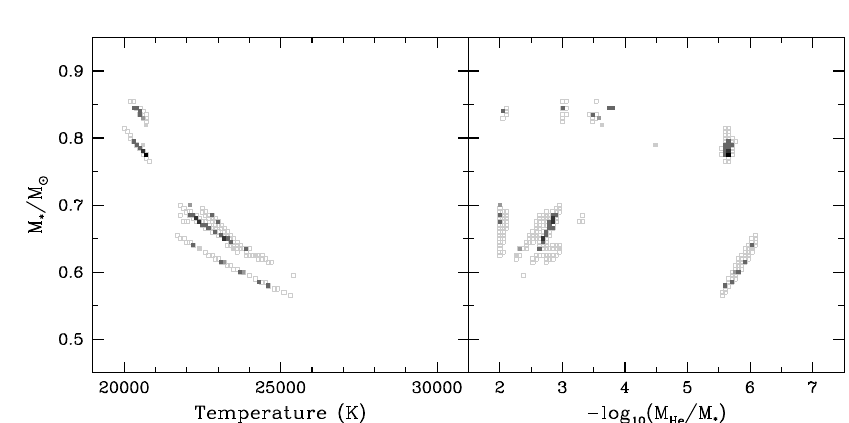
Fig. 2. The distribution of globally optimal model parameters for the 100 simulated data sets created using random m -values from the observed modes in GD 358. The families of models from the m =0 case in Figure 2 are shown in outline for comparison. Again the shade indicates root- mean-square period differences less than 3 seconds (lightest), 2.75, 2.5, 1.75, and 1.5 seconds